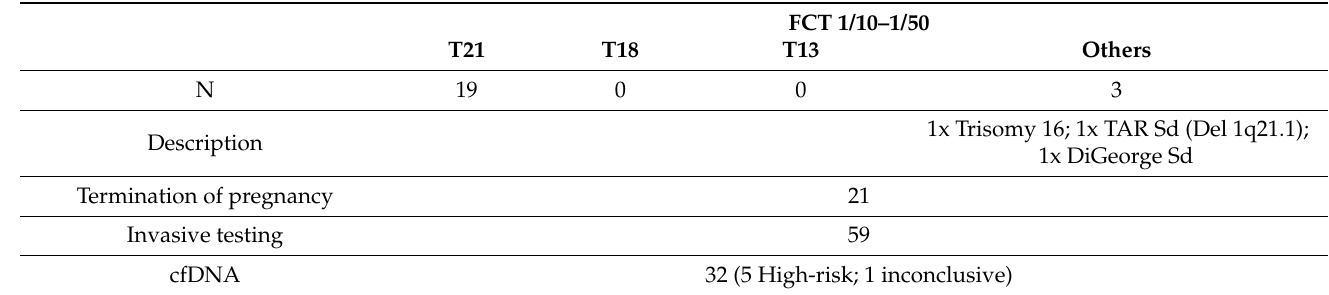
Table 2. Group with an FCT between 1/10 and 1/50.